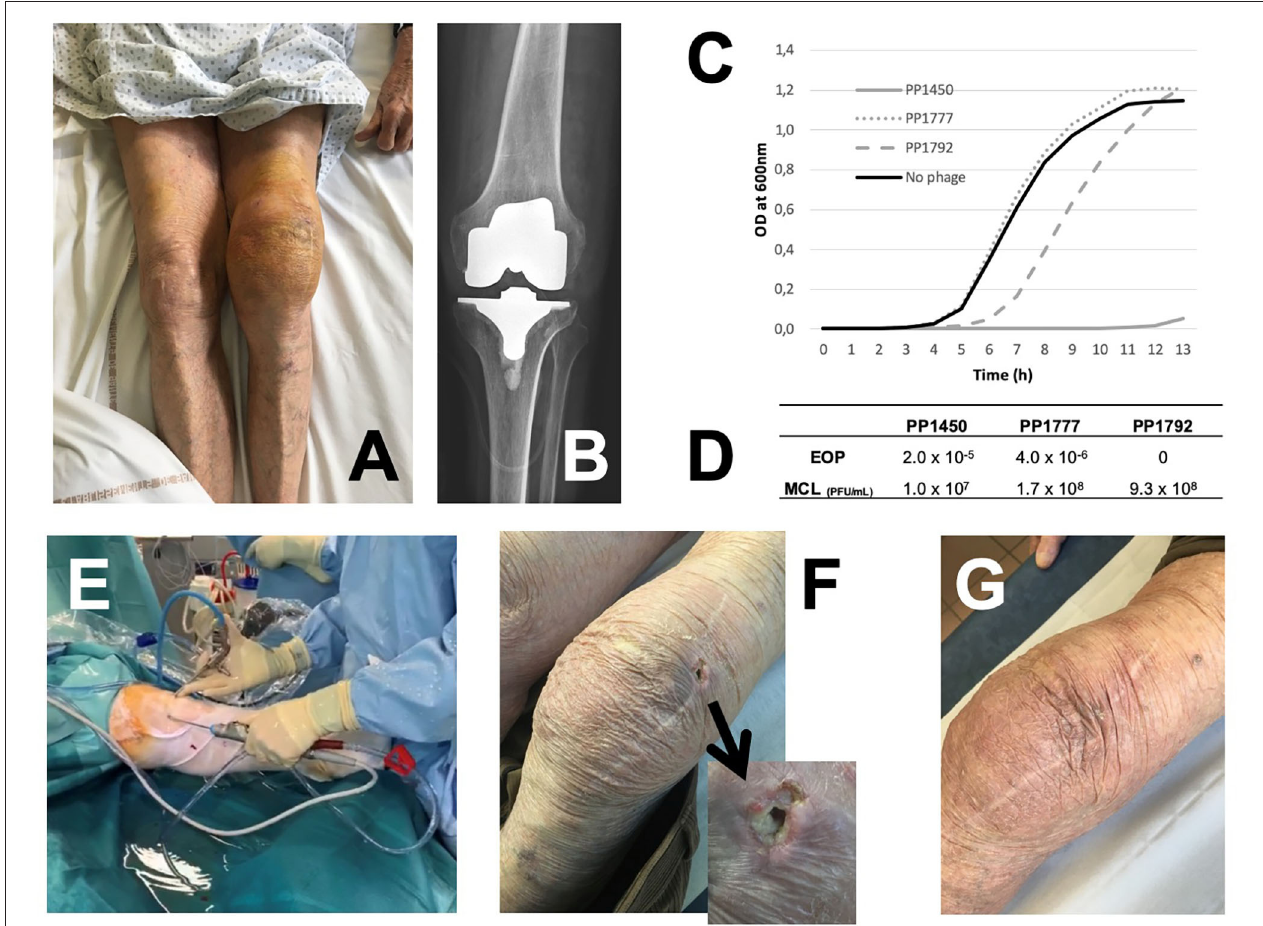
FIGURE 1 | (A) Left knee joint effusion due to relapsing P. aeruginosa prosthesis knee infection; (B) X-ray showing no prosthesis loosening. The susceptibility of the patient’s strain to the bacteriophages PP1450, PP1777, and PP1792 (phagogram) was performed using two complementary techniques: (C) For the kinetic assay, phages were incubated at a theorical multiplicity of infection (MOI, ratio of phages/bacteria) equal to 100 with the patient’s strain. PP1450 was able to inhibit the bacterial growth (gray full line); PP1792 delayed the bacterial growth (gray dotted line) and PP1777 had no impact (gray dashed line). (D) For the plaque assay, titers obtained with the patient’s strain and the reference strain are determined to calculate the efficiency of plating score (EOP) score (the closer to 1 is the score, the more efficient the phage is). Phages PP1450 and PP1777 were active on the patient’s strain with an EOP score of 2.0 × 10 − 5 and 4.0 × 10 − 6 , respectively. Partial lysis without PFU were observed for PP1792 (considered to have a weak bactericidal or bacteriostatic activity in this assay). (E) Arthroscopic DAIR with administration of the phage cocktail at the end of the procedure through the arthroscope. (F) Ulceration of a subcutaneous nodule on the external side of the knee observed 2 months after the arthroscopy. (G) Finally, a favorable outcome under suppressive antimicrobial